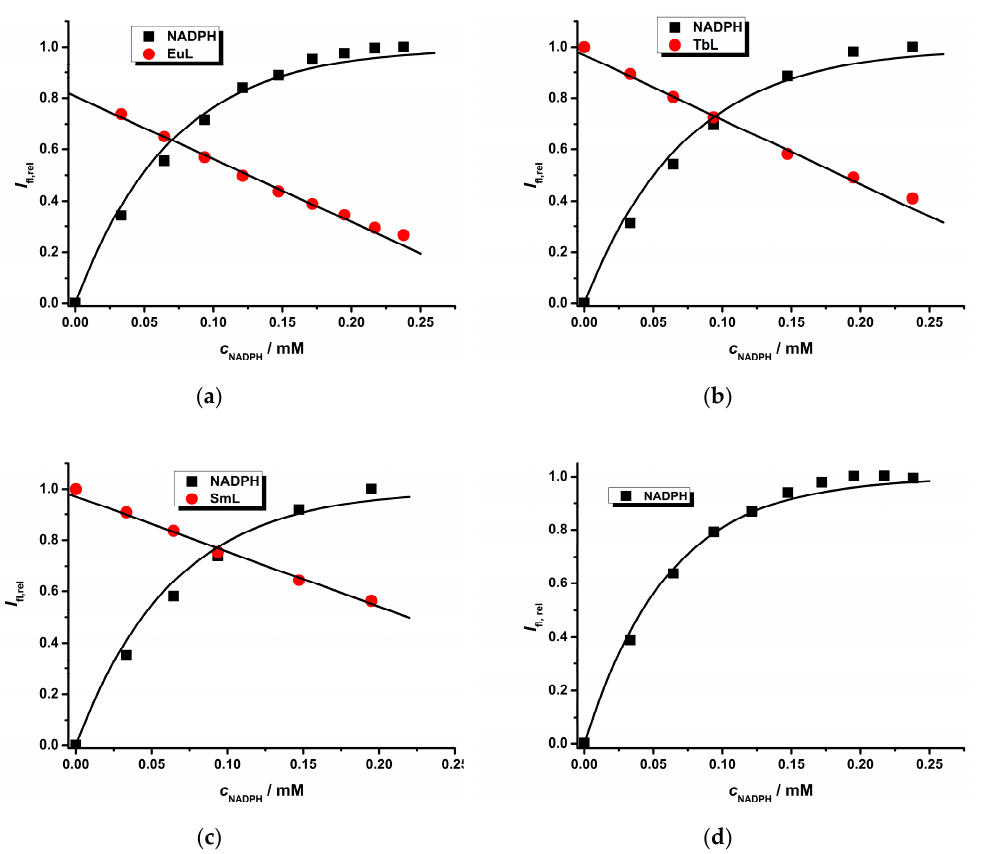
Figure 4. The quenching effect of NADPH on the luminescence intensity of ternary Eu(III) ( a ), Tb(III) ( b ) and Sm(III) ( c ) complexes with DO3A macrocyclic and IQCA ligands (  exc = 325 nm, pH = 7.5 (40 and Sm(III) ( c ) complexes with DO3A macrocyclic and IQCA ligands ( λ exc = 325 nm, pH = 7.5 (40 mM mM HEPES), c Ln ∼ 0.2 mM, c DO3A ∼ 0.3 mM, c IQCA ∼ 0.3 mM). The self-quenching effect of NADPH HEPES), c Ln ~ 0.2 mM, c DO3A ~ 0.3 mM, c IQCA ~ 0.3 mM). The self-quenching e ff ect of NADPH ligand is ligand is also demonstrated ( d ).  em_NADPH = 460 nm,  em_EuL = 618 nm,  em_TbL = 545 nm,  em_SmL = 597 also demonstrated ( d ). λ em_NADPH = 460 nm, λ em_EuL = 618 nm, λ em_TbL = 545 nm, λ em_SmL = 597 nm.